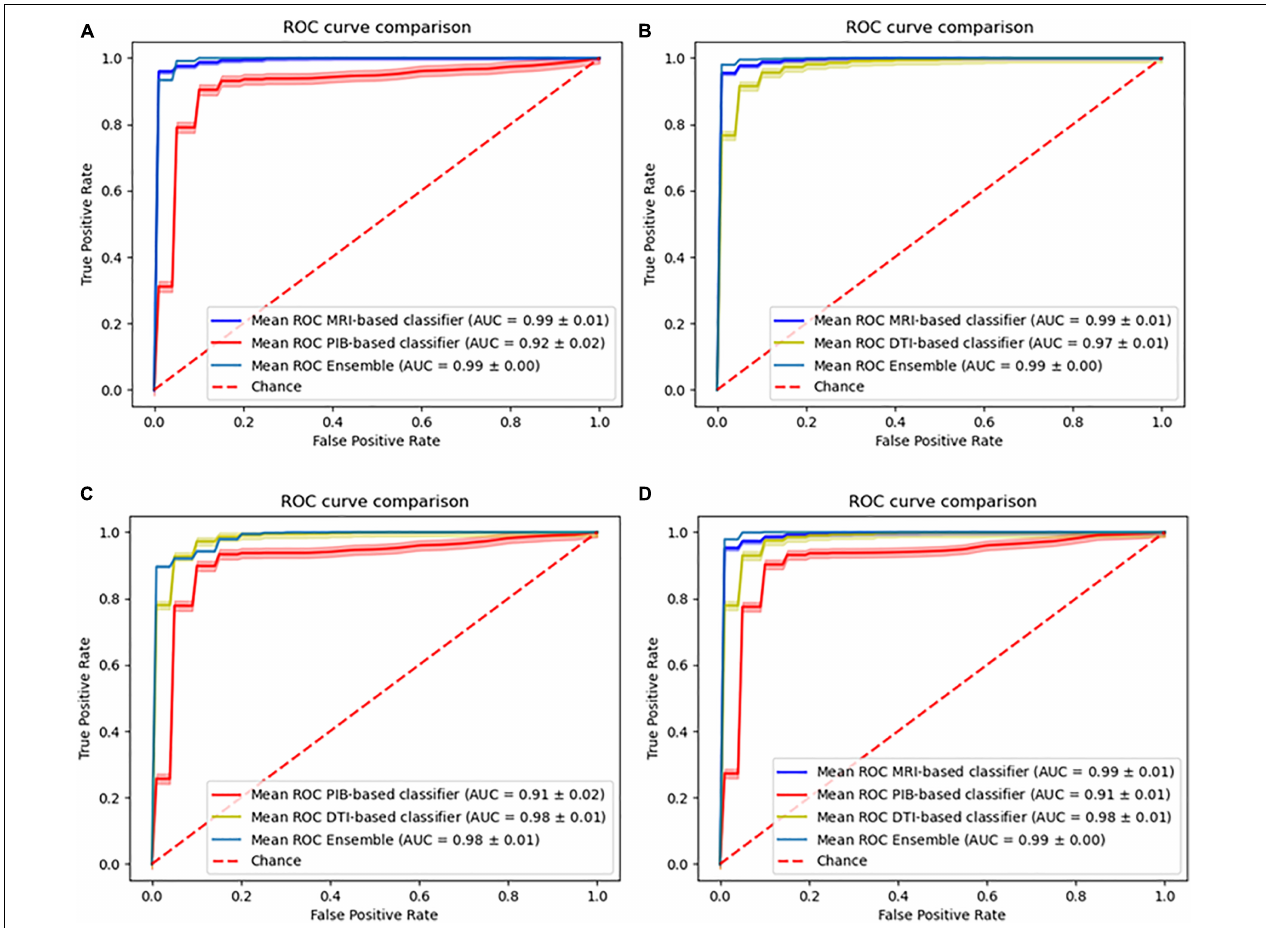
FIGURE 3 | Comparison of the ROC curves of the individual models and the ensemble models. (A) Combination of MRI with PiB-PET, (B) Combination of MRI with DTI, (C) Combination of PiB-PET with DTI, (D) Combination of